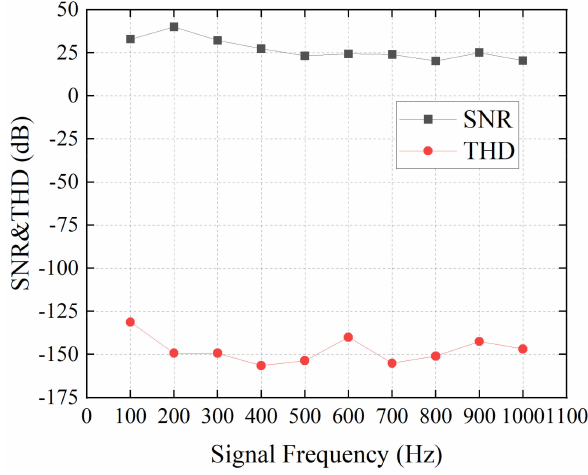
Figure 10. SNR and THD of the restored signal with different signal frequency.